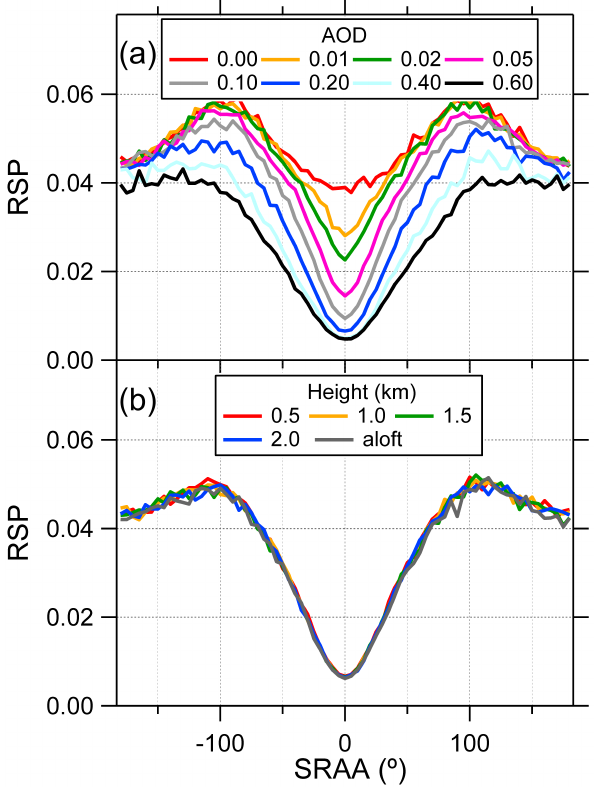
Figure 4. Sensitivity study showing that simulated RSP (430nm) is (a) a strong function of AOD and (b) insensitive to the aerosol vertical distribution. (a) AOD is varied, keeping aerosols homo- geneously distributed (box profile) up to 1.5km altitude. (b) The aerosol extinction vertical distribution is varied for a constant AOD of 0.2. The simulation is for SZA = 70 ◦ , SSA = 0.98, g = 0.70, SA =